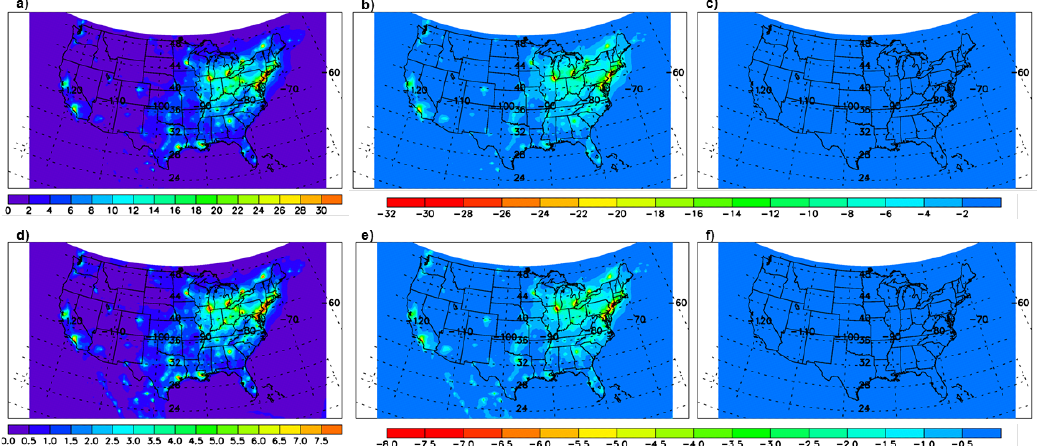
Figure 9. February 2050 average NO x concentrations (ppbv) simulated by CMAQ for the A1FI (top) and B1 scenarios (bottom). Each row contains the BL scenarios (left: a and d ), differences (ppbv) between the BL and H 2 -FC scenarios (center: b and e ), and differences (ppbv) between the BL and H 2 -ICE scenarios (right: c and f ). Data are from the lowest model level ( ∼ 100 m). Note that the scales are different among panels.